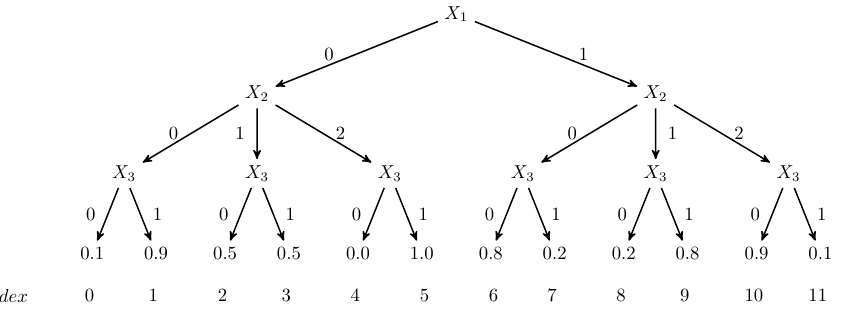
Figure 3. φ ( X 1 , X 2 , X 3 ) as PT .